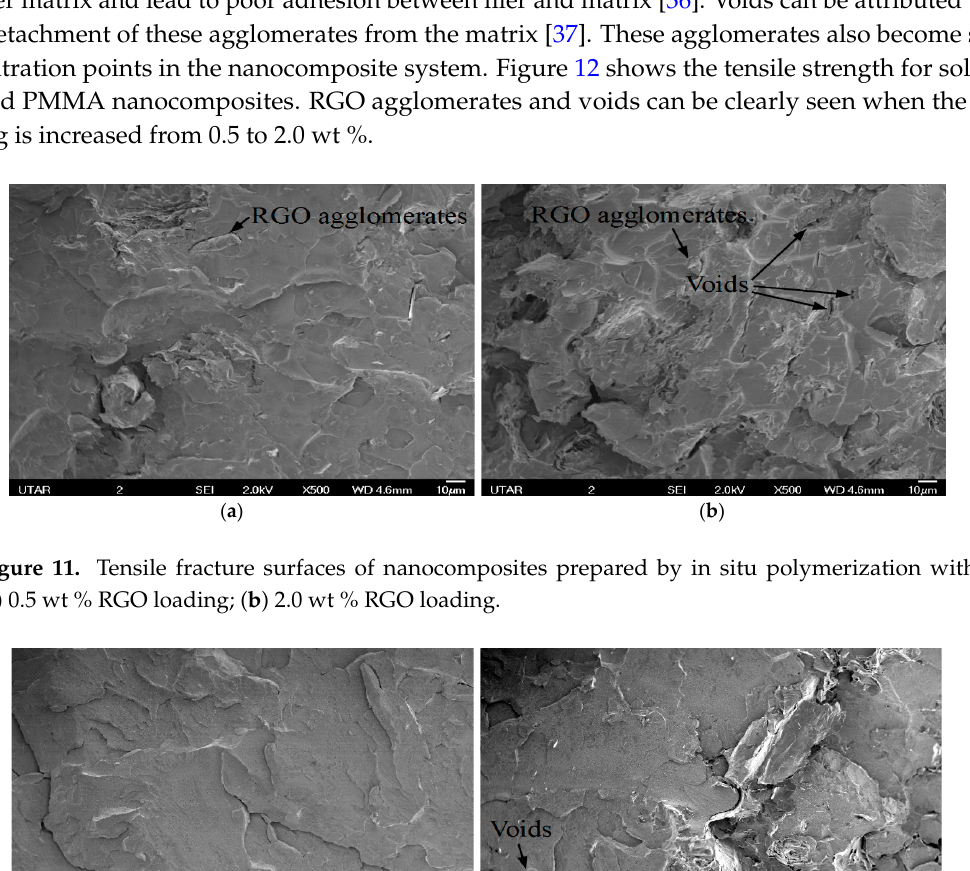
Figure 12. Tensile fracture surfaces of nanocomposites prepared by solution blending with different RGO loading. ( a ) 0.5 wt % RGO loading; ( b ) 2.0 wt % RGO loading.